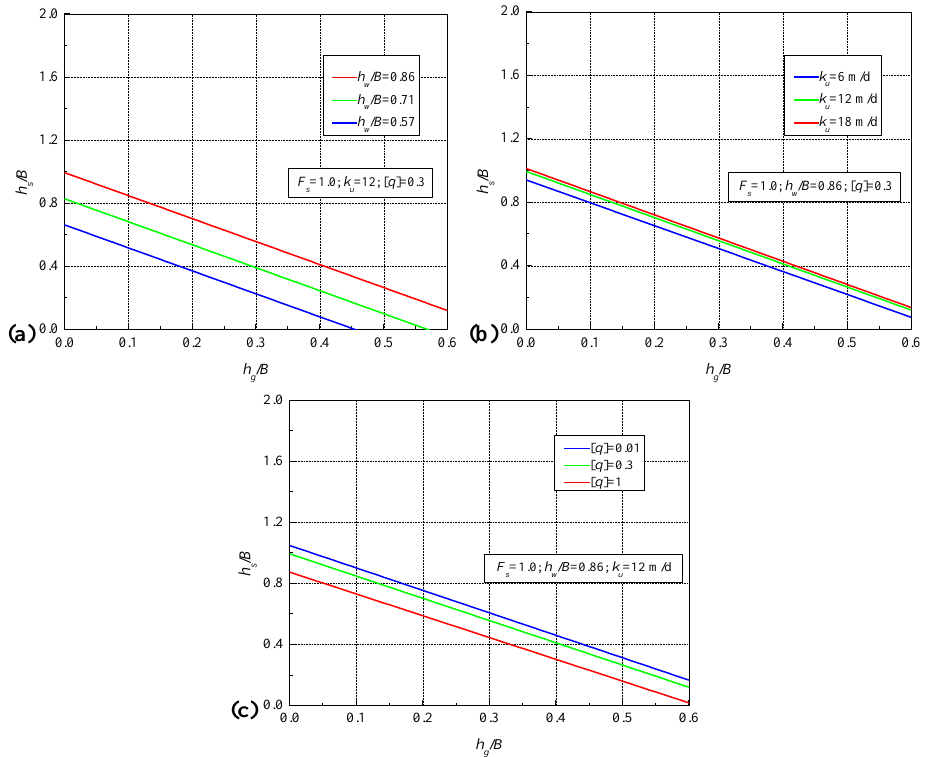
Figure 5. Relation curves of h g / B versus h g / B when considering “instability failure”: ( a ) water table; and, ( b ) unconfined compression strength.